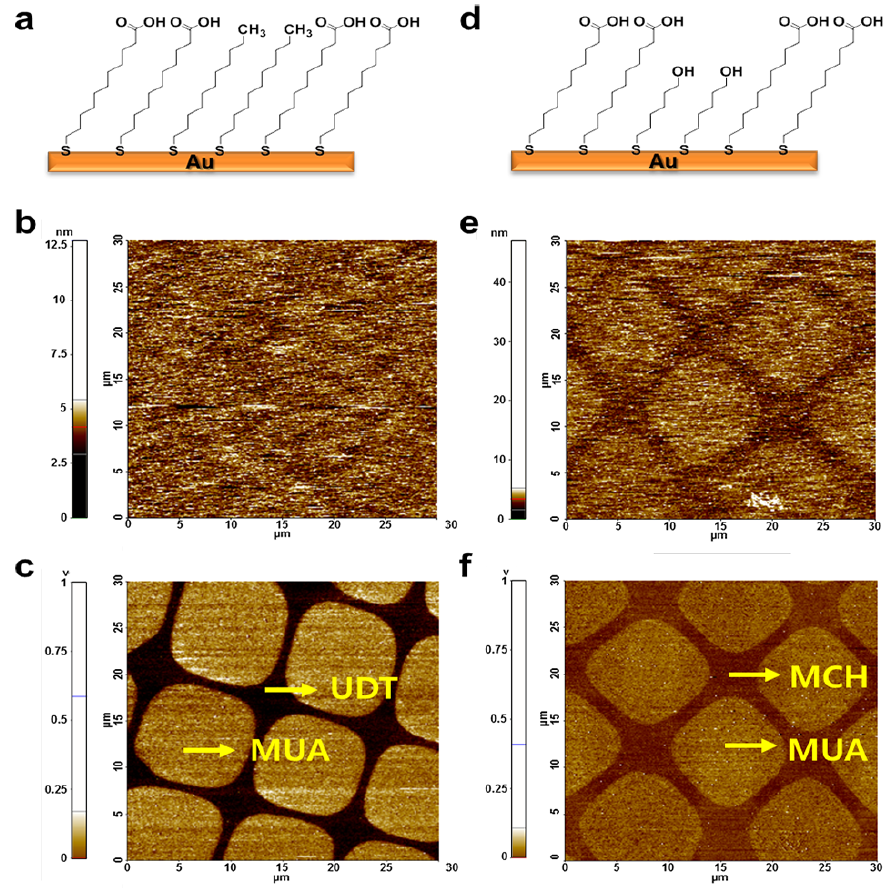
Figure 2. Chemical structures of MUA/UDT ( a ) and MUA/MCH; ( b ) and MUA/MCH; ( c ) and MUA/MCH; ( d ) the topography image of MUA/UDT; ( e ) the lateral force image of MUA/UDT; ( f ) using a silicon